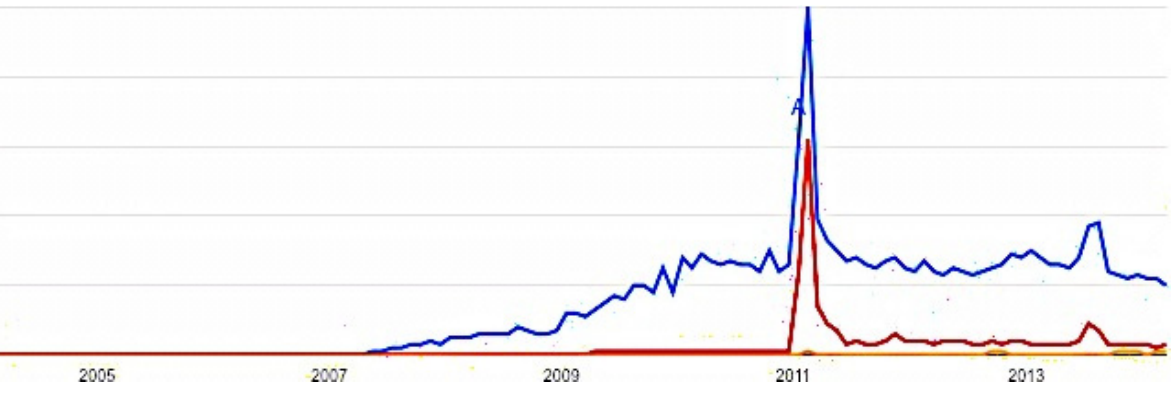
Figure 6. Dynamics of popularity of Facebook, Twitter and Google Docs (in descending order) in Egypt by year. Source : Google Trends